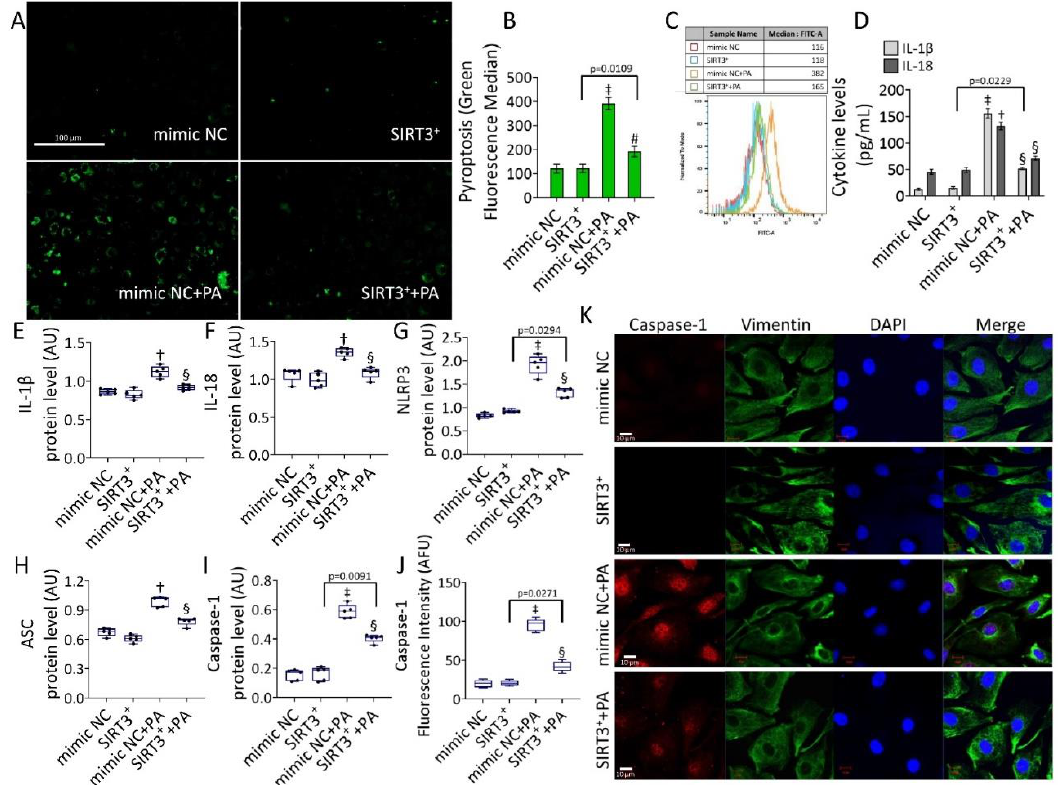
Figure 5. SIRT3 + reduced the PA-mediated pyroptosis. ( A ) Representative images and ( B , C ) cytometer analysis, expressed as green fluorescence median, of pyroptosis (scale bars = 100 µm). ( D ) Cytokine levels and immunoblotting analysis of ( E ) IL- 1β, ( F ) IL-18, ( G ) NLRP3, ( H ) ASC, and ( I ) caspase-1. ( J ) Fluorescence intensity and ( K ) representative images of confocal laser scanning microscopy (scale bars = 10 µm) of caspase-1 in EC transfected with mimic Negative Control (mimic NC), SIRT3 mimic (SIRT3 + ), mimic Negative Control and then exposed to 0.5 mM PA for 48 h (mimic NC+PA) or SIRT3 mimic before 48 h treatment with PA (SIRT3 + +PA). Fluorescence analysis ( n = 5) is reported as boxplots of arbitrary fluorescence units (AFU), protein expression levels ( n = 5) ex- pressed as arbitrary units (AU). † p < 0.01 vs. mimic NC; ‡ p < 0.001 mimic NC; § p < 0.05 vs. mimic NC+PA; # p < 0.01 vs. mimic NC+PA.